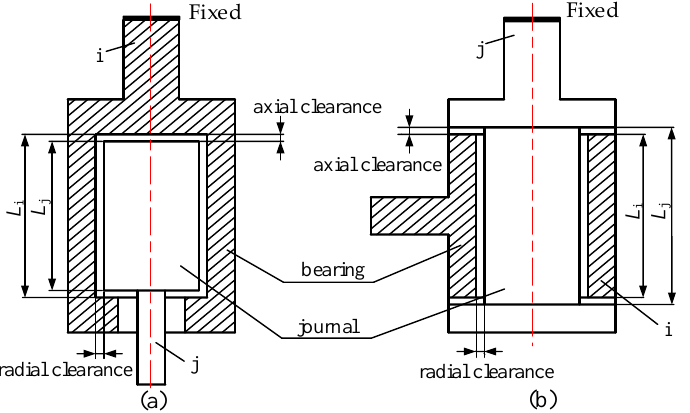
Figure 1. Combination forms of a revolute joint. ( a ) The bearing is fixed and the journal has axial or radial offset with respect to the bearing. ( b ) The journal is fixed and the bearing has axial or radial offset with respect to the journal.